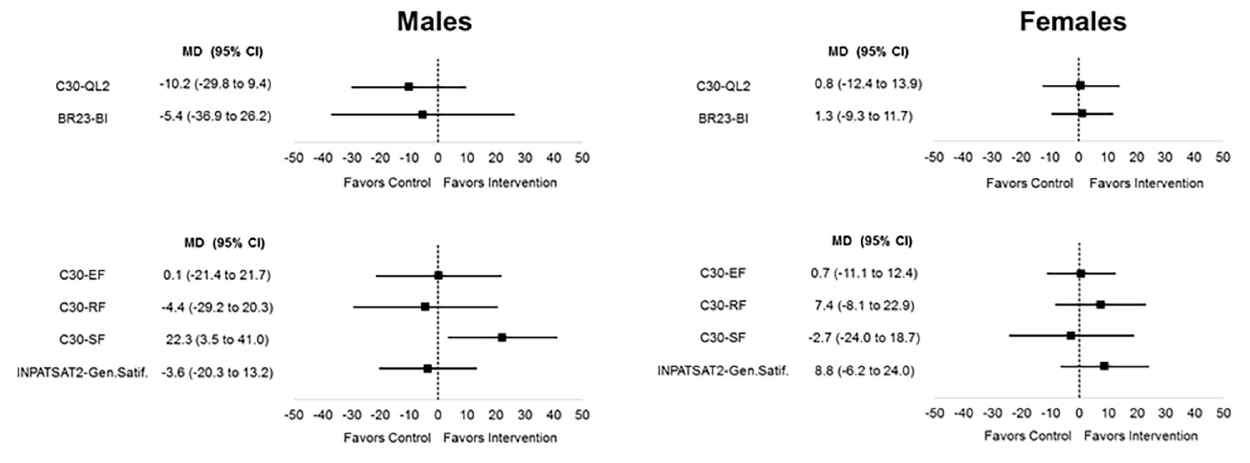
aimed to alleviate body image-related distress after breast cancer treatment through a single-session,